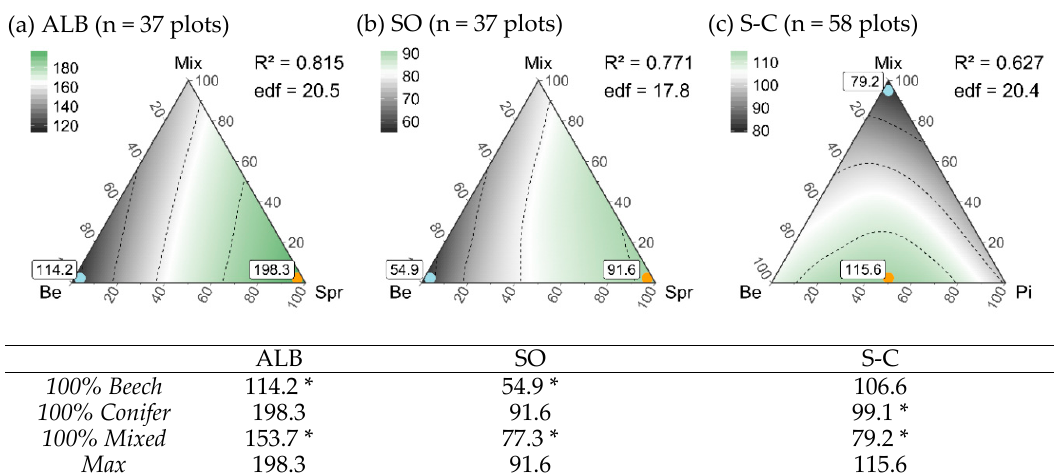
Figure A2. Number of exclusive vascular plant species in relation to the number of resampled plots in pure beech and conifer stands and respective mixtures in ( a ) Schorfheide-Chorin (S-C) and ( b , c ) northwestern Germany (NW), ( d ) Solling (SO) and ( e ) Schwäbische Alb (ALB). Note that y-axis of ALB is double the size of the other regions.